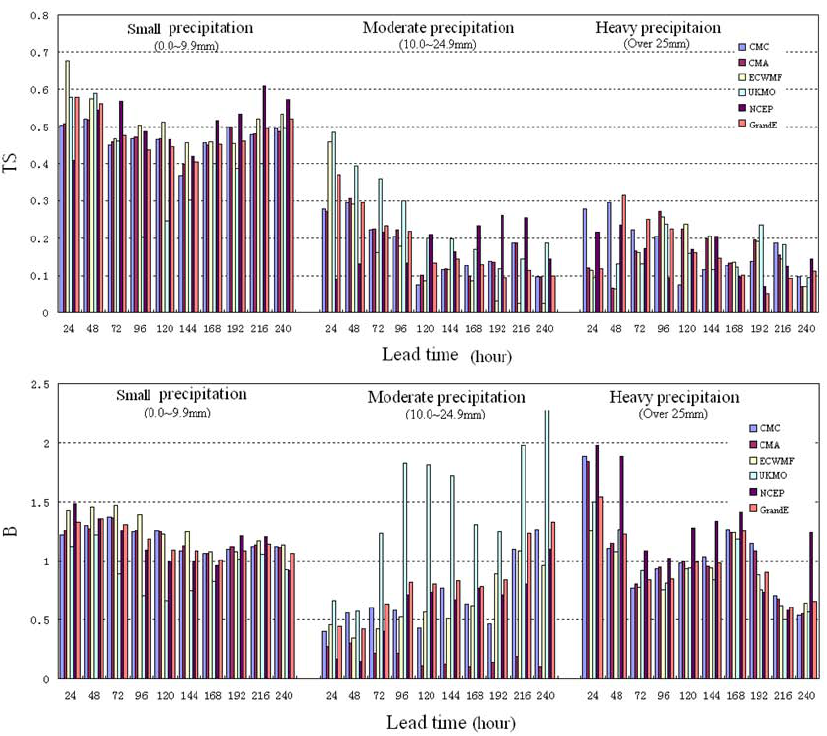
Fig. 3. Threat Score (top) and Bias Error (bottom). Yes/no forecast verification of the three category precipitation obtained from CMC, CMA, ECWMF, UKMO, NCEP and their grand ensemble (GrandE) over the Xixian catchment.